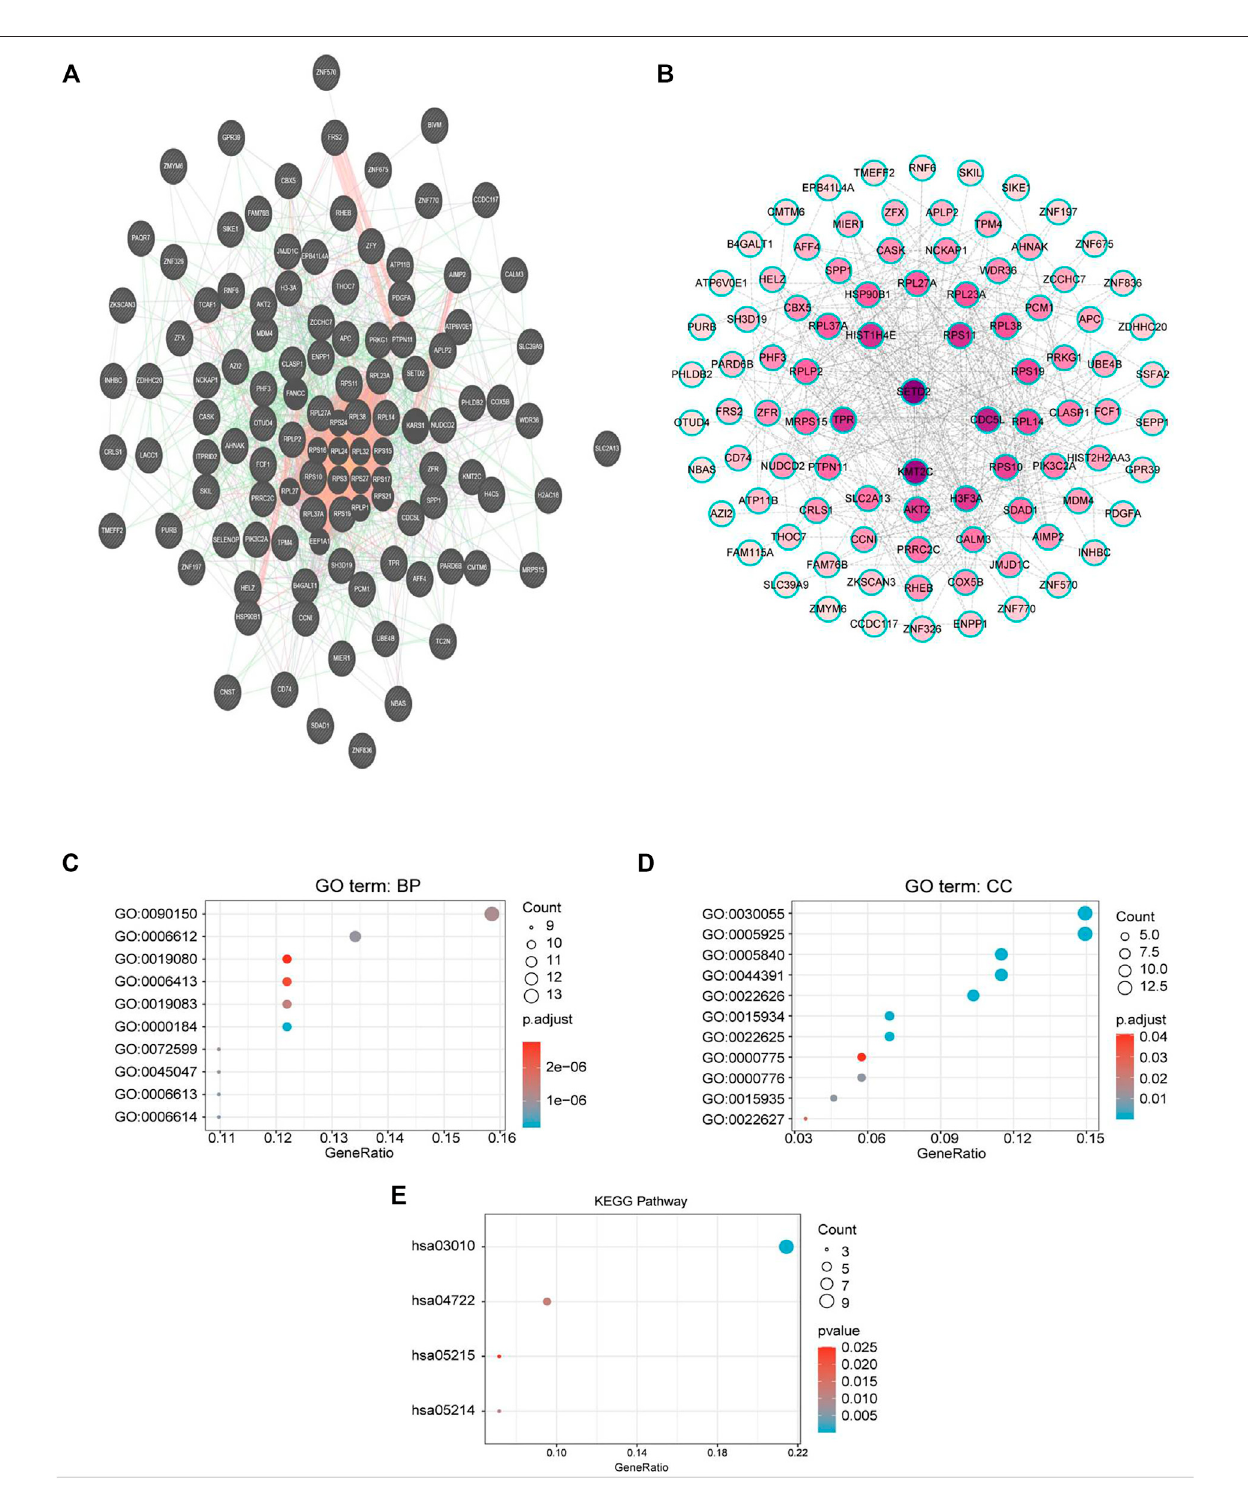
FIGURE6| PPInetworkandGO/KEGGenrichmentanalysisofgenescoexpressedwithCMTM6. (A) PPInetworkofgenescoexpressedwithCMTM6constructed in the GeneMANIA database. (B) Visualization of a GeneMANIA-derived network complex of molecular interactions in Cytoscape pathway visualization. (C,D) Enriched GO terms in the “ biological process ” and enriched GO terms in the “ cellular component ” ; the top 10 are displayed. (E) KEGG pathway annotations. The X-axis represented the proportion of coexpressed genes, and the Y-axis represented different categories. The different colors indicate different properties, and the different sizes represent the number of